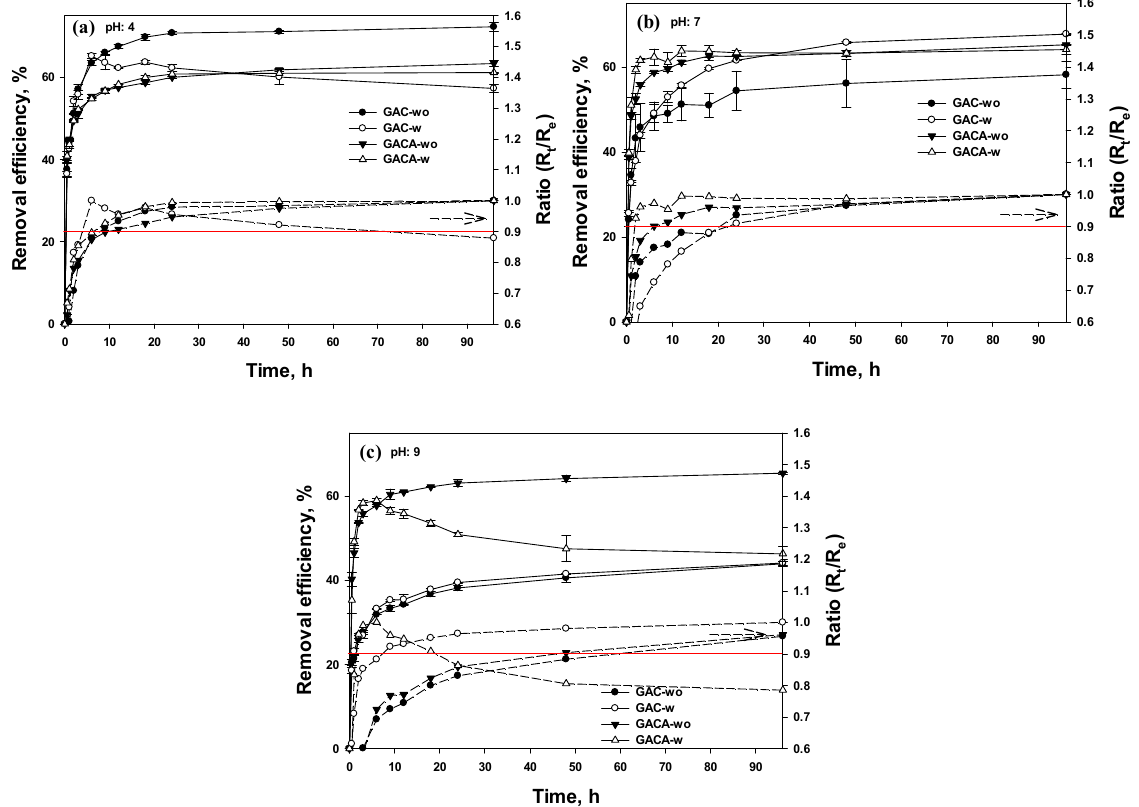
Figure 6. Phosphate removal efficiency (%) (left y-axis) and removal efficiency ratio (R t /R e ) (right y-axis) as a function of time (h) at initial pH of 4 ( a ), 7 ( b ), and 9 ( c ).